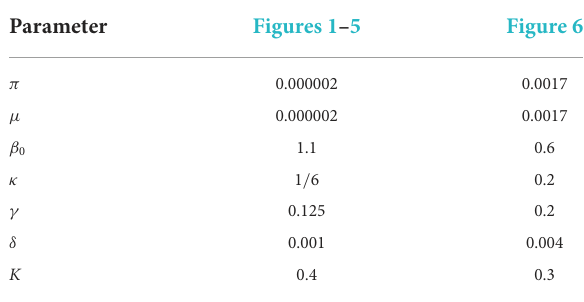
TABLE 2 Parameter values used in